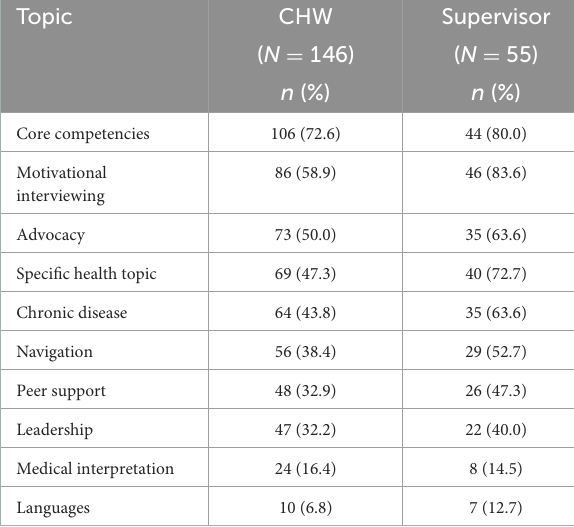
TABLE 3 Employer-offered training for CHWs reported by a national sample of CHWs and CHW supervisors working with Medicaid managed care